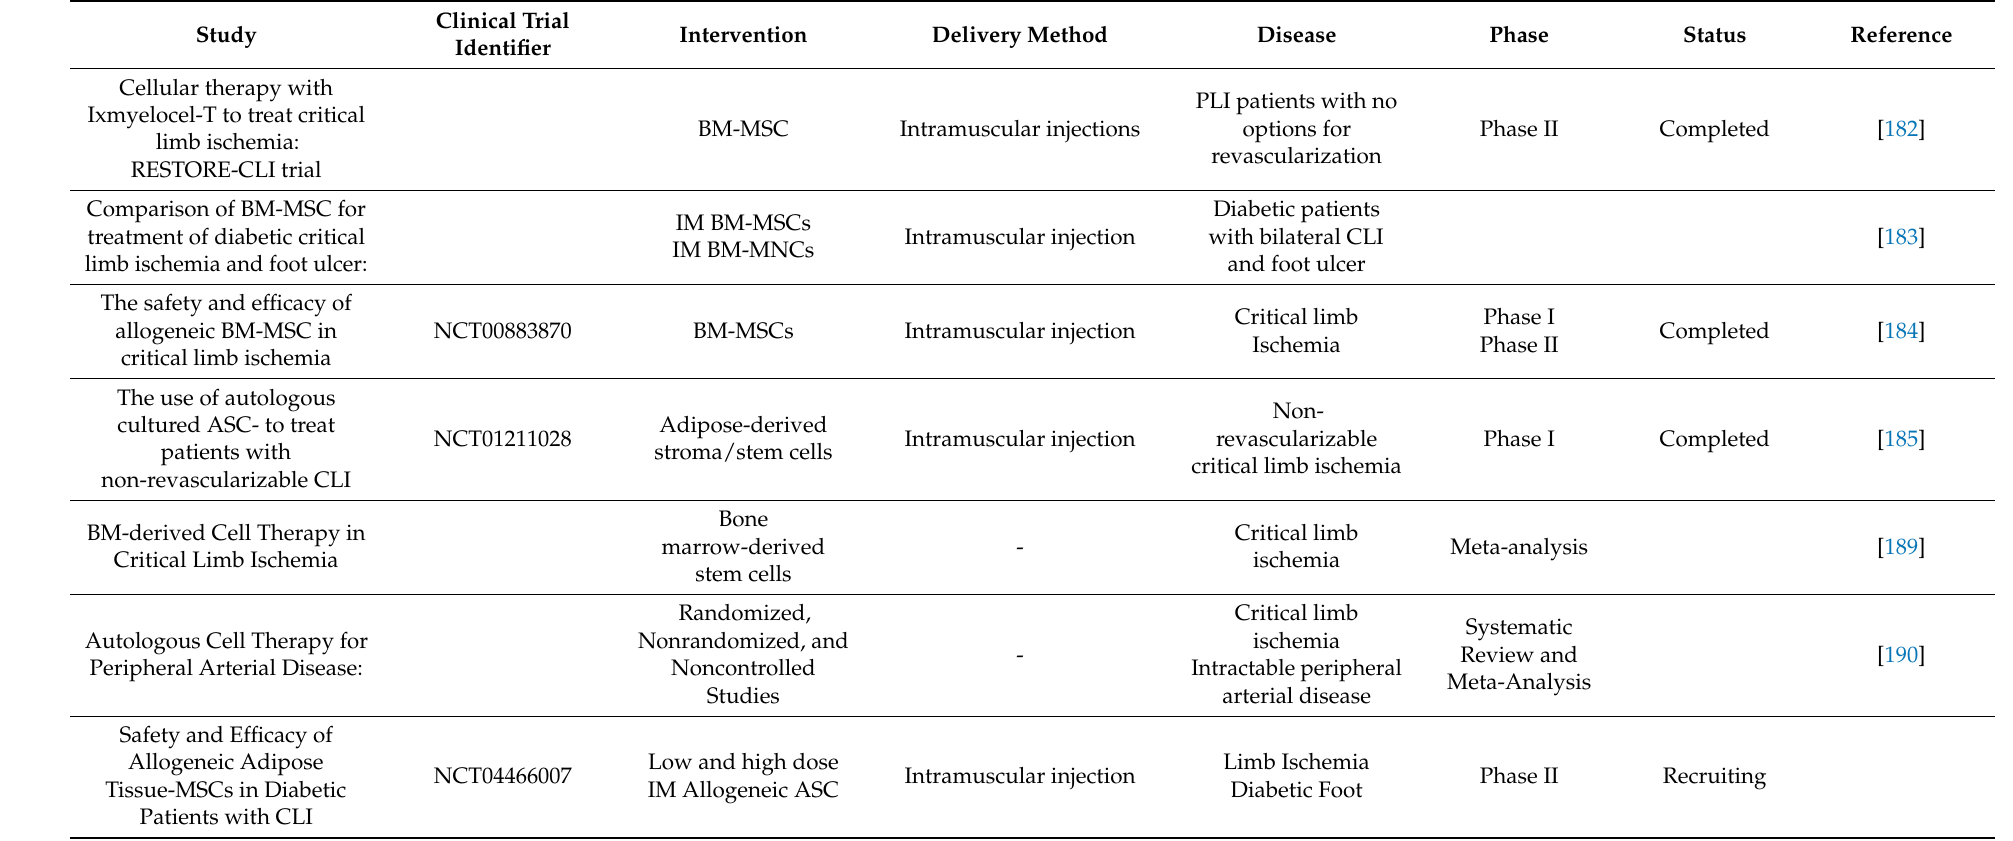
Table 4. Clinical Trials that utilized MSCs in peripheral limb